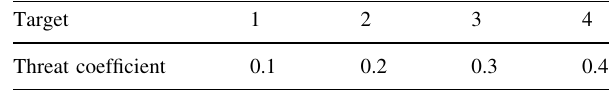
Table 4 Target threat coefficient for case